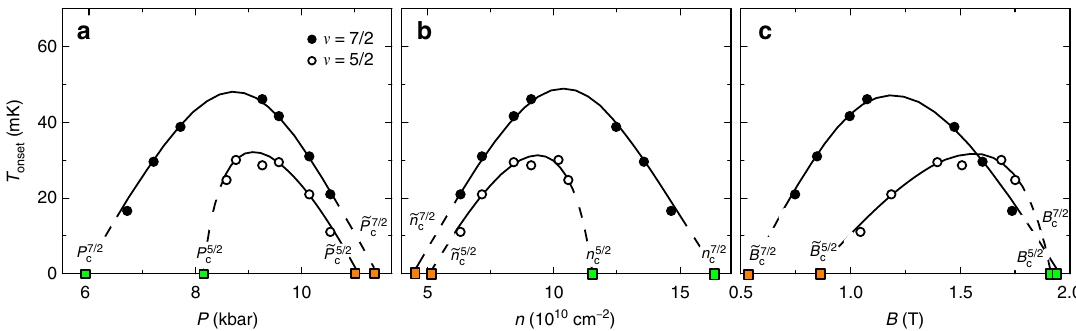
Fig. 4 The dependence of the nematic onset temperature on various parameters. The onset temperatures of the nematic at ν = 5/2 and 7/2 in sample A is plotted as function of pressure ( a ), electron density ( b ), and magnetic fi eld ( c ). Green and orange squares are the estimated critical points of the paired-to- nematic and nematic-to-Fermi fl uid quantum phase transitions, respectively. Lines are guides to the